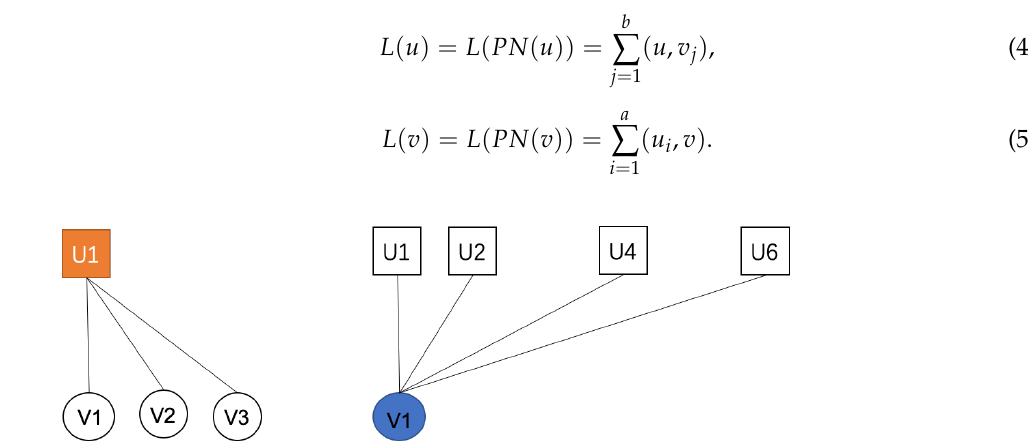
Figure 3. All node pairs containing nodes U 1 and V 1. In a bipartite network G = ( U , V , E ) , NeiPN ( u , v ) represents a set of neighbor node pairs of node pairs (u,v).